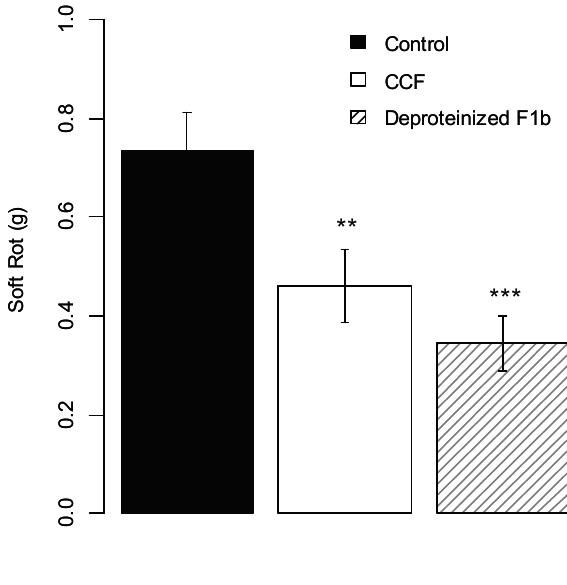
Figure 8. Protection effect of deproteinized F1b (400 µg/slice) on potato tubers slices against Pectobacterium atrosepticum . Values are means of replicates of two independent experiments with two blocks ± standard errors. Bars with different stars subscripts